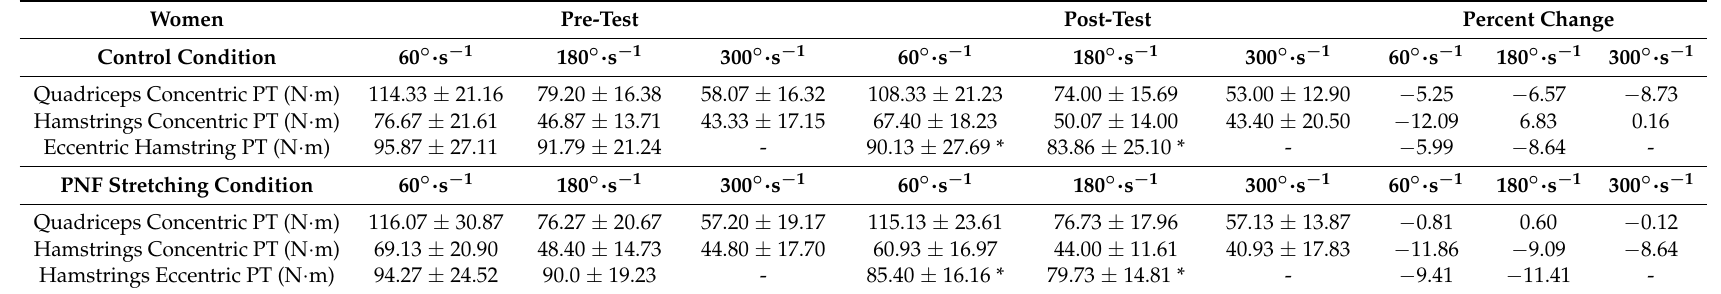
Table 2. Mean values ± SD of quadriceps and hamstrings concentric PT, and hamstrings eccentric PT for